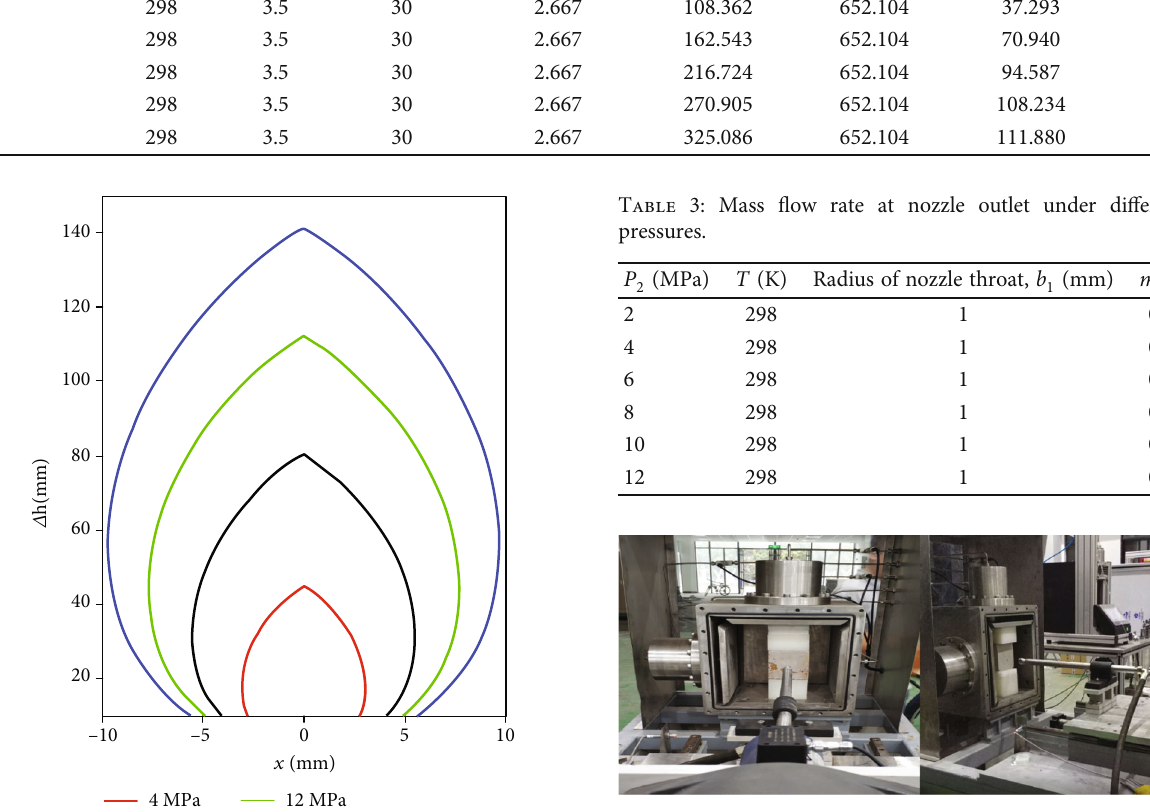
Figure 7: Physical diagram of a test block fi xing device.